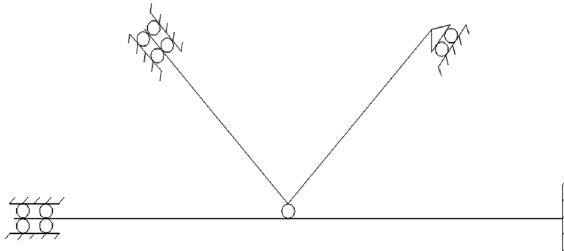
Figure 13. Boundary conditions.